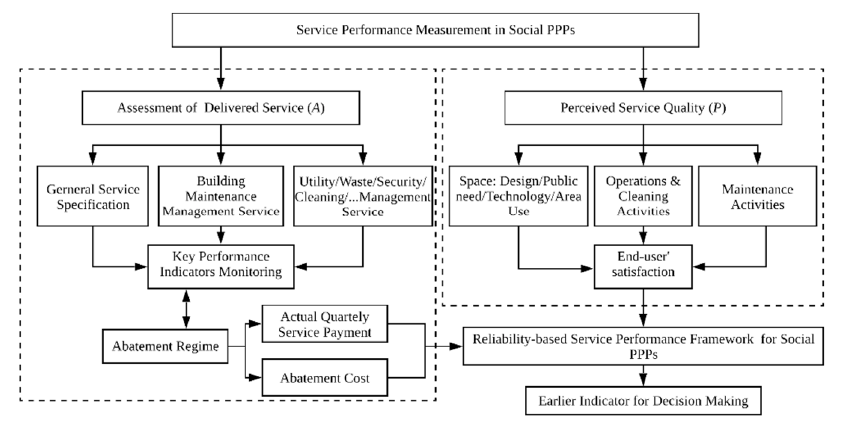
Figure 2. Conceptual reliability-based decision support